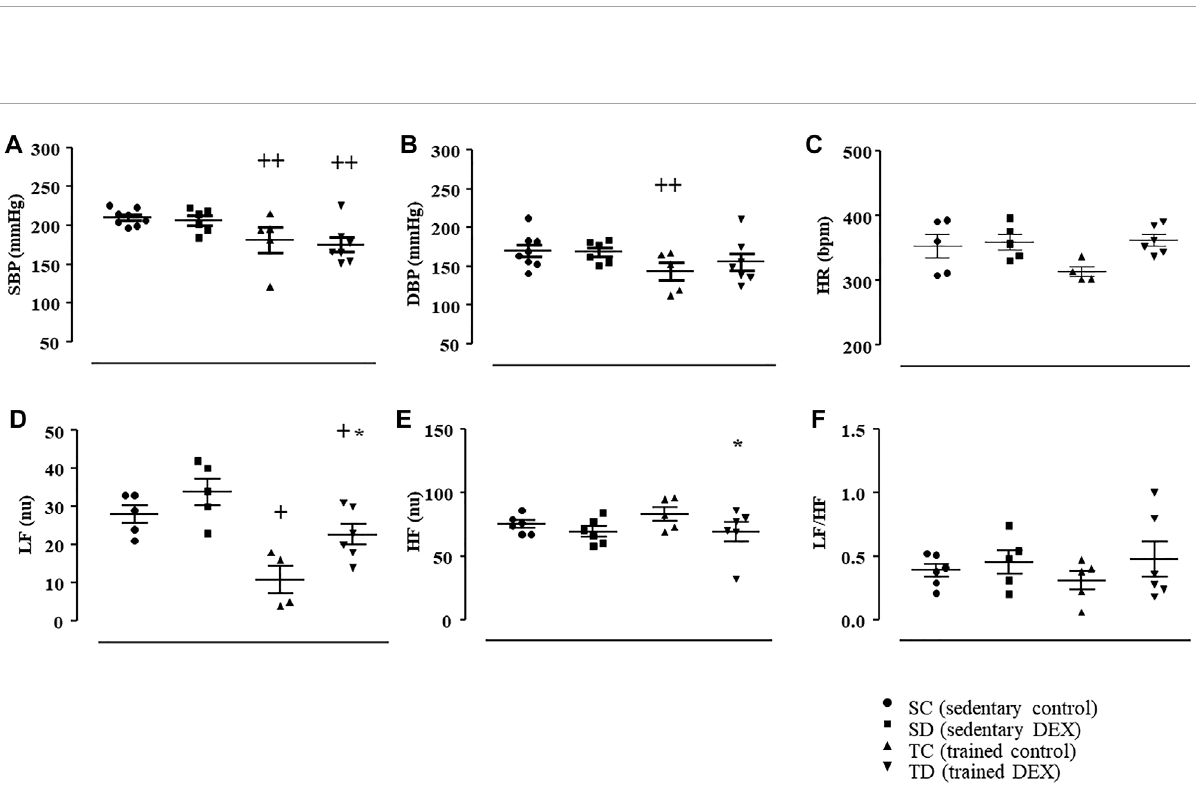
FIGURE 4 Values of systolic blood pressure (SBP, mmHg, Panel (A) ; diastolic blood pressure (DBP, mmHg, Panel (B) ; heart rate (HR, bpm, Panel (C) . Analysis of autonomic balance to the heart. Low frequency band (LF, nu, Panel (D) ; high frequency band (HF, nu, Panel (E) ; ratio of LF and HF (LF/HF, Panel (F) inallSHRgroups:Sedentarycontrol(SC, n =6),SedentarytreatedwithDEX(SD, n =6),Trainedcontrol(TC, n =5),TrainedtreatedwithDEX (TD, n = 7). Signi fi cance: * vs . Control, + vs . Sedentary; p <